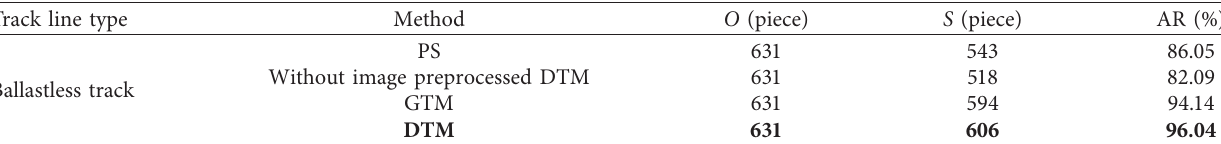
Table 2: Comparison of positioning